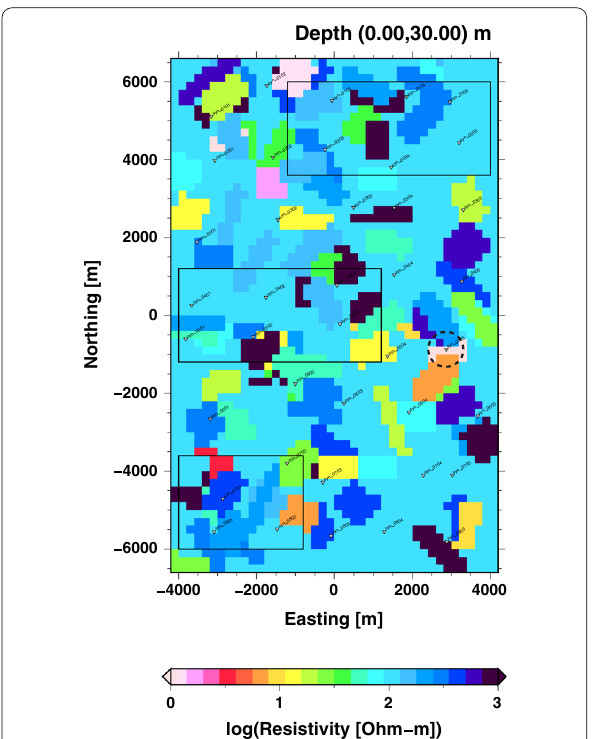
Fig. 20 Plan view of near‑surface distorters with a typical length scale of 1000 m. Their resistivity values follow the normal distribution in Eq. (32). The frames with solid lines represent the locations of underlying conductive and resistive anomalies (see Fig. 1). An example of PTATAN from a strongly distorted station (syn‑0505) indicated by the dashed circle is shown in Fig. 22